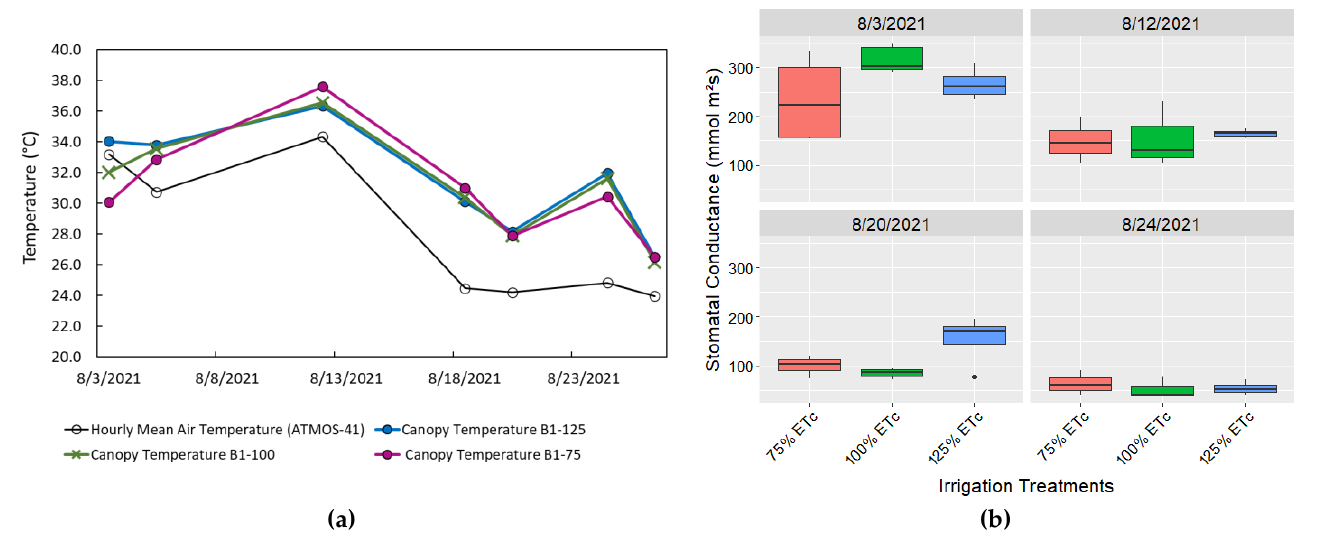
Figure 7. ( a ) Canopy temperature at different irrigation levels of 75% ET c , 100% ET c and 125% ET c compared to the hourly mean air temperature measured by ATMOS-41. ( b ) Measured stomatal conductance of the crop under different irrigation levels in Block 1.